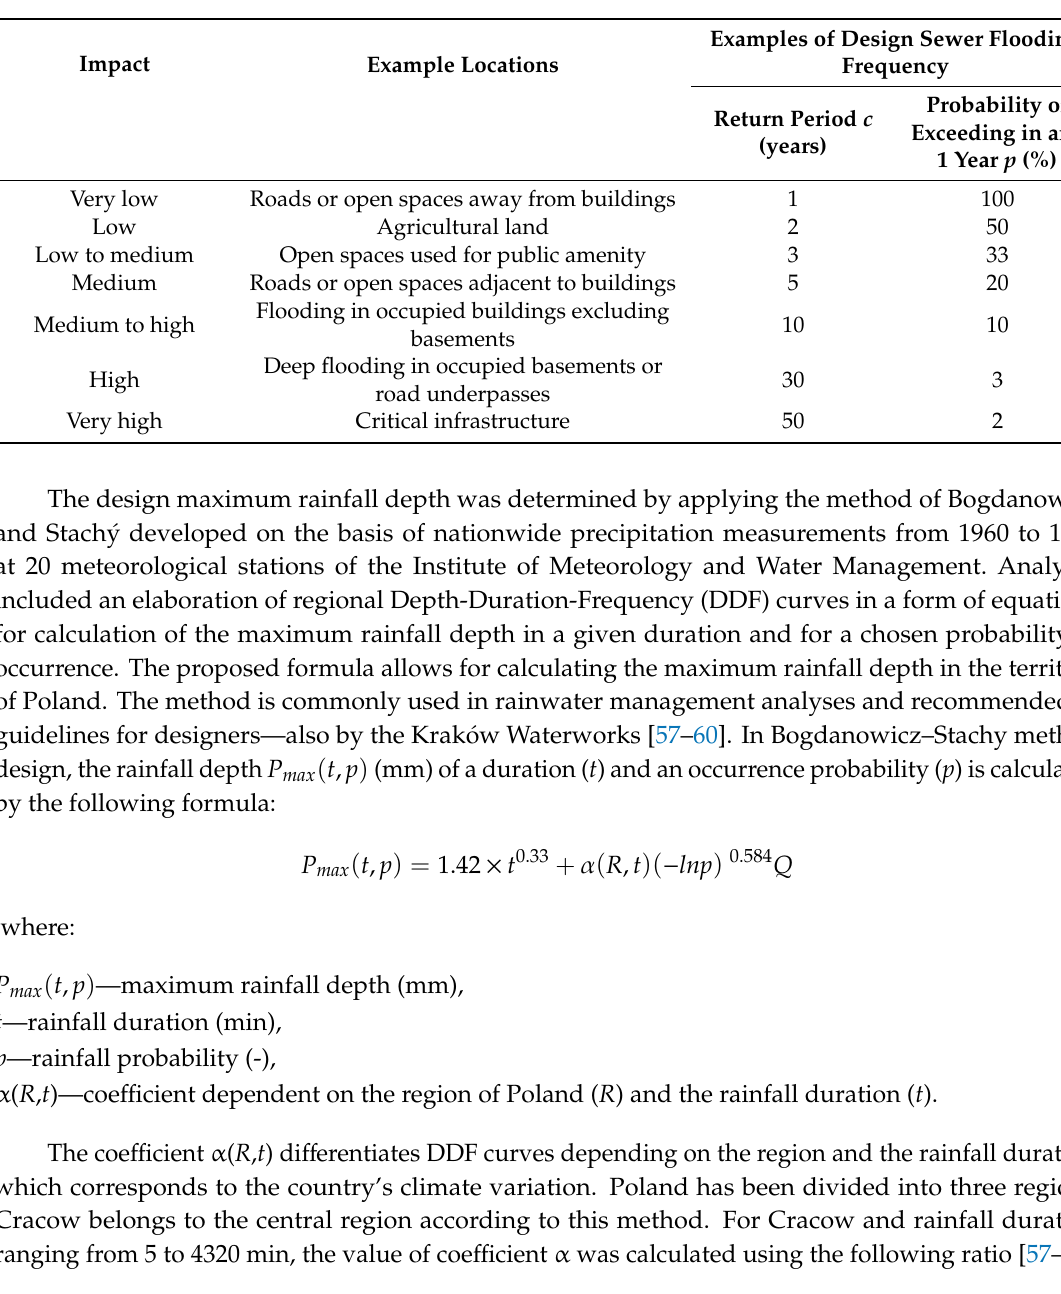
Table 1. Examples of design sewer flooding criteria and acceptable frequencies of flooding from sewers according to Reference